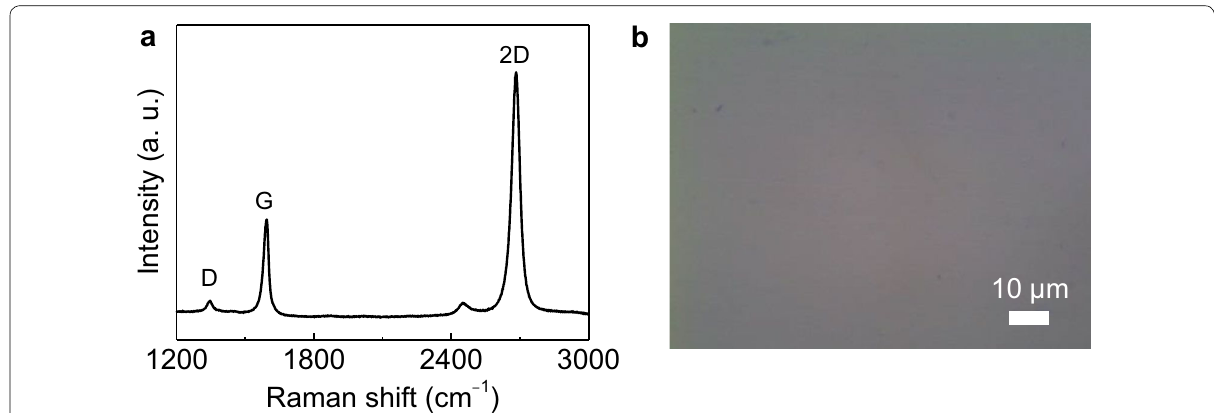
Fig. 1 a Raman spectrum and b optical image of a monolayer graphene sheet transferred on a Si/SiO 2